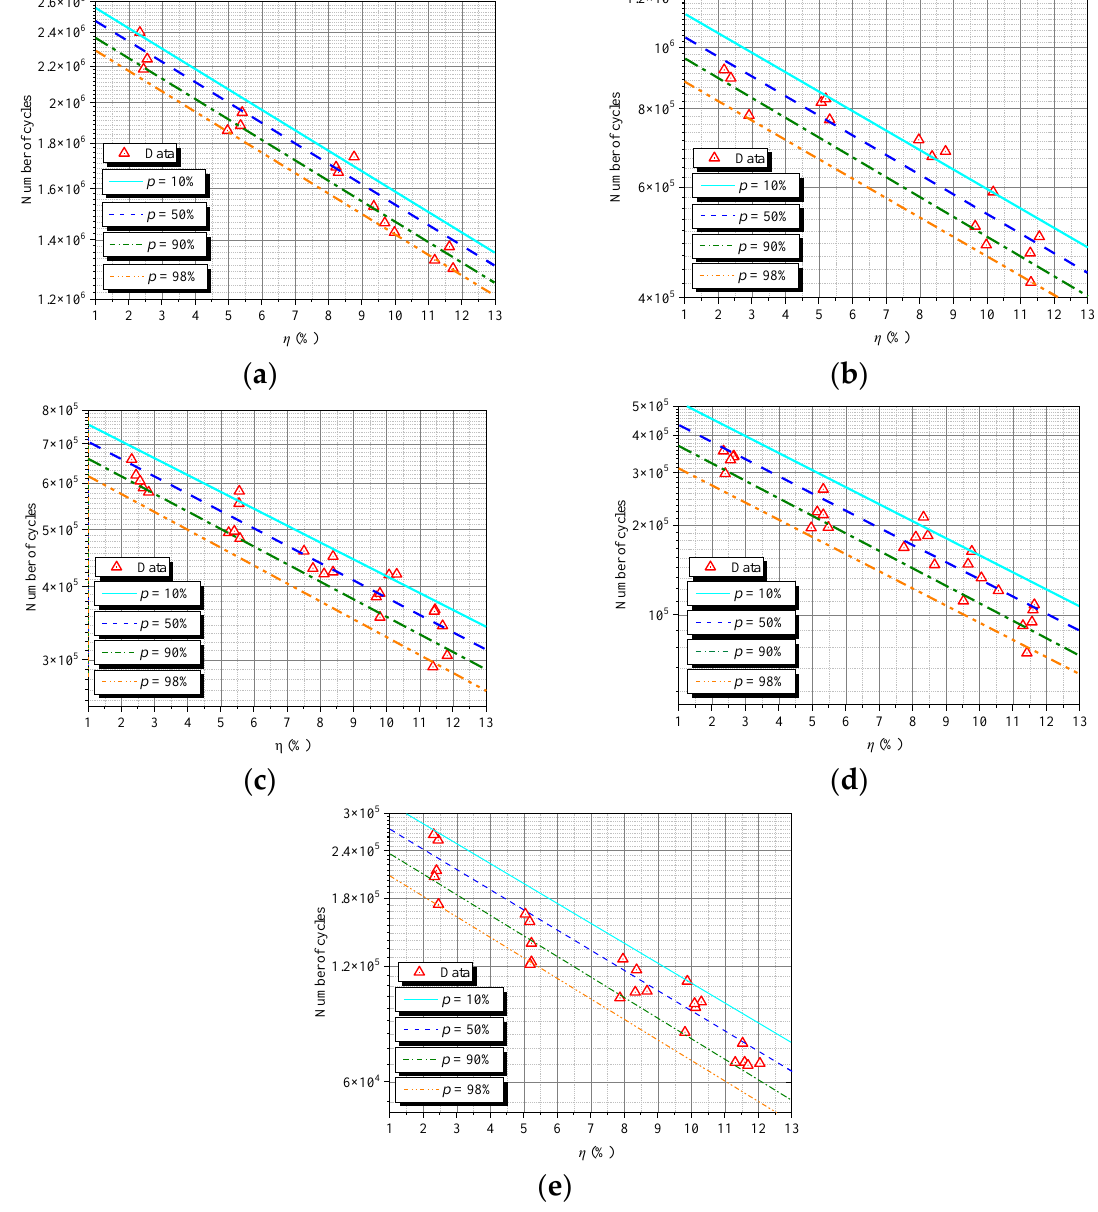
Figure 18. Fatigue life versus corrosion degree for steel wire. ( a ) Δ S = 270 MPa, ( b ) Δ S = 360 MPa, ( c ) Δ S = 450 MPa, ( d ) Δ S = 540 MPa and ( e ) Δ S = 630 MPa.